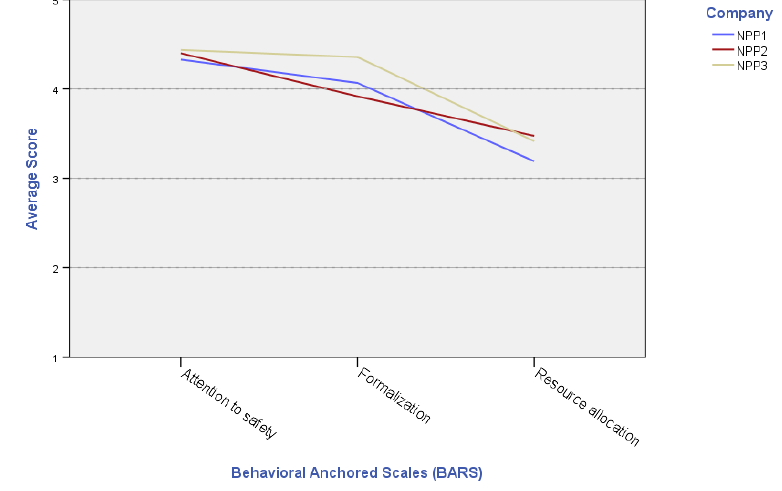
Figure 5. BARS averages by company.